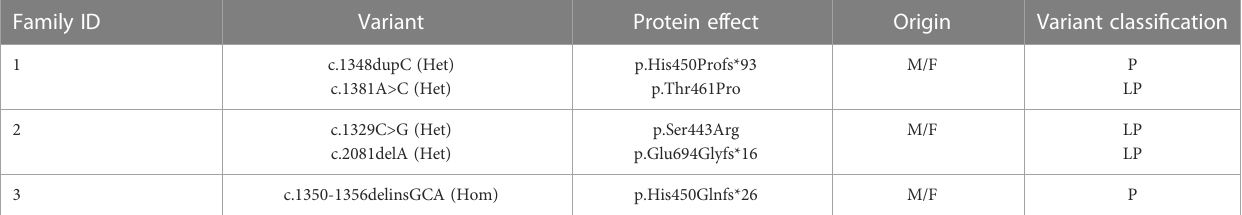
TABLE 2 Genotype characteristics.